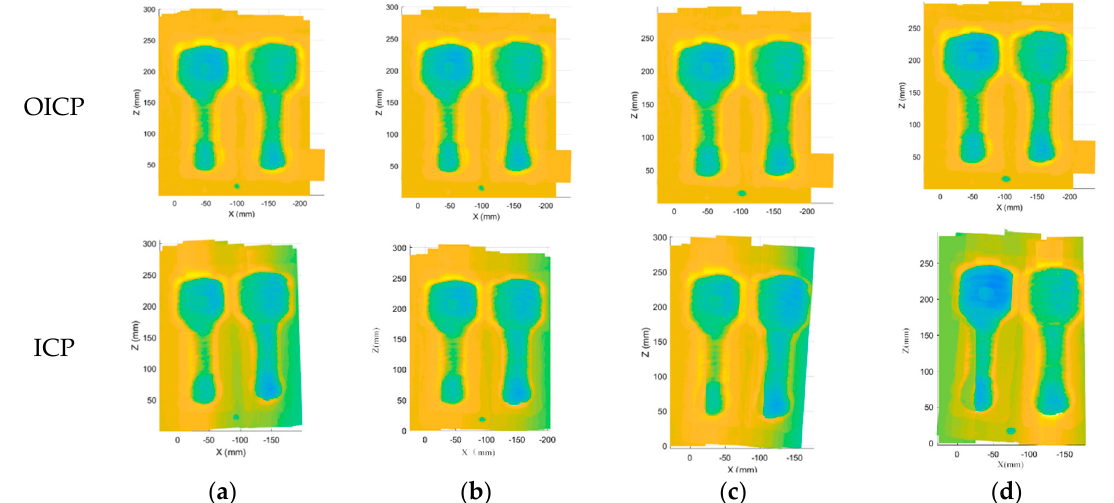
Figure 8. The effect of point cloud registration of ICP and OICP at a high overlap rate ( ≥ 60%): overlap = ( a ) 90%; ( b ) 80%; ( c ) 70%; ( d ) 60%.